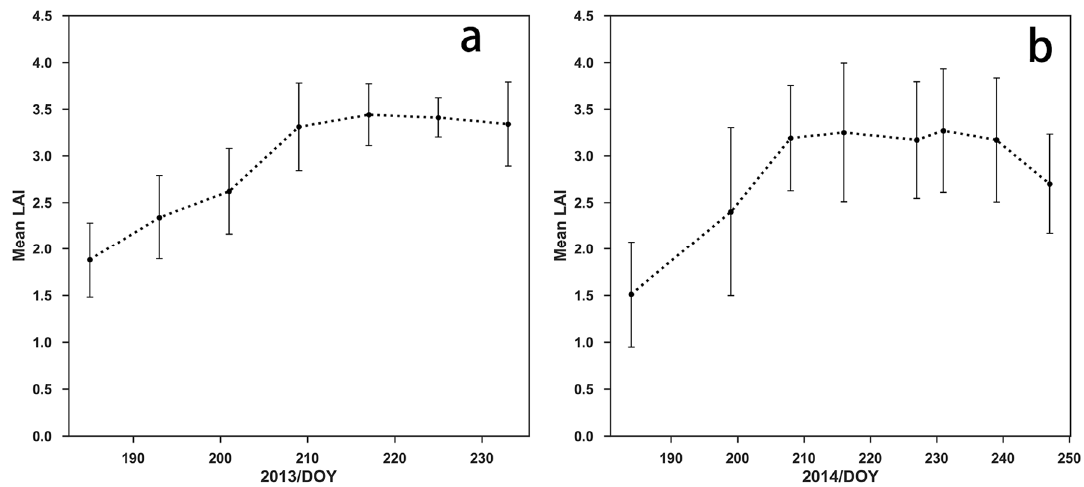
Figure 4. Temporal variation in mean LAI at the Huailai sites. The error bars are the standard deviation: ( a ) The measuring instrument in 2013 was LAINet. ( b ) The measuring instrument in 2014 was LAI-2000.